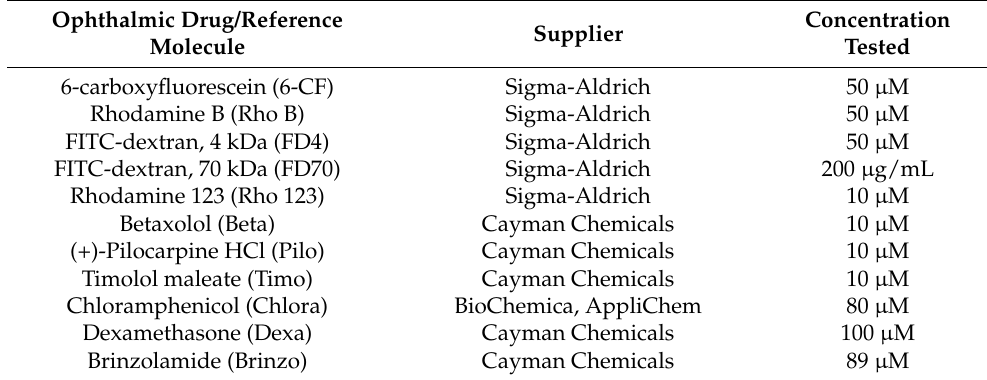
Table 1. Ophthalmic drugs and reference molecules tested in the permeability